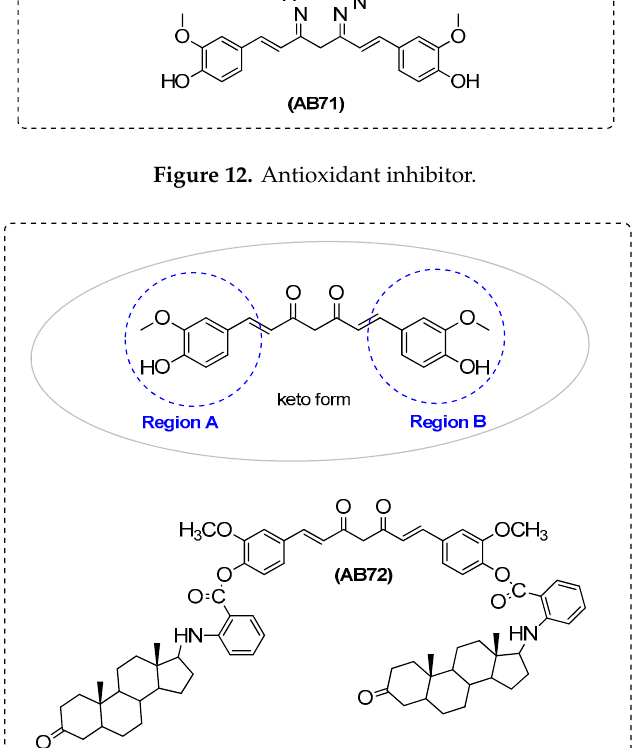
Figure 13. Antioxidant